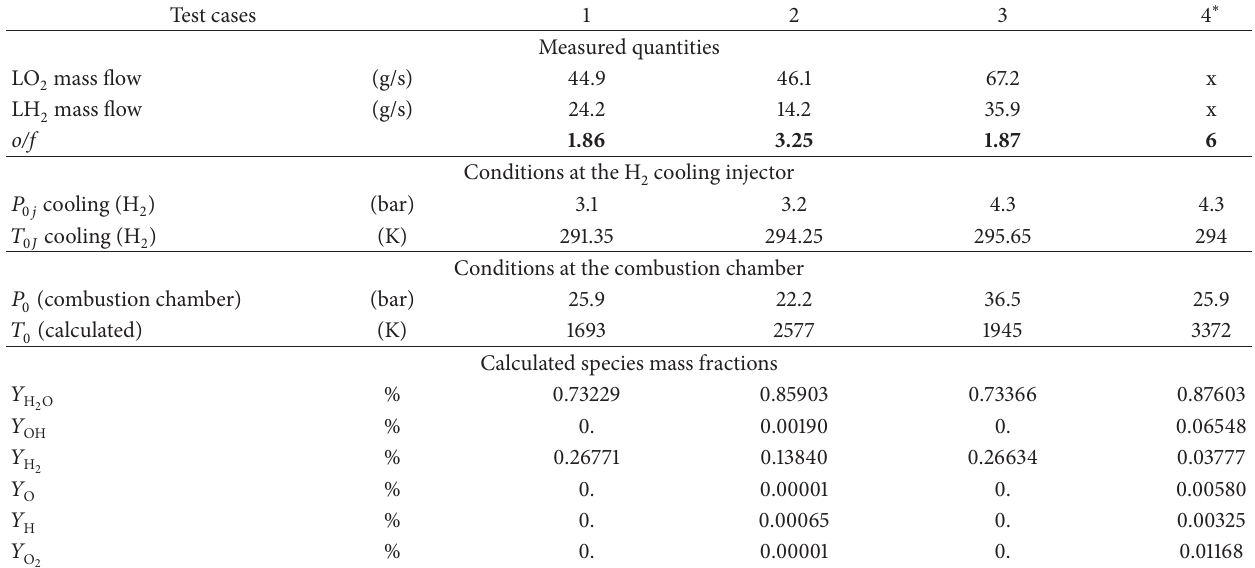
Table 3: Operating test cases conditions and initial inputs for CFD